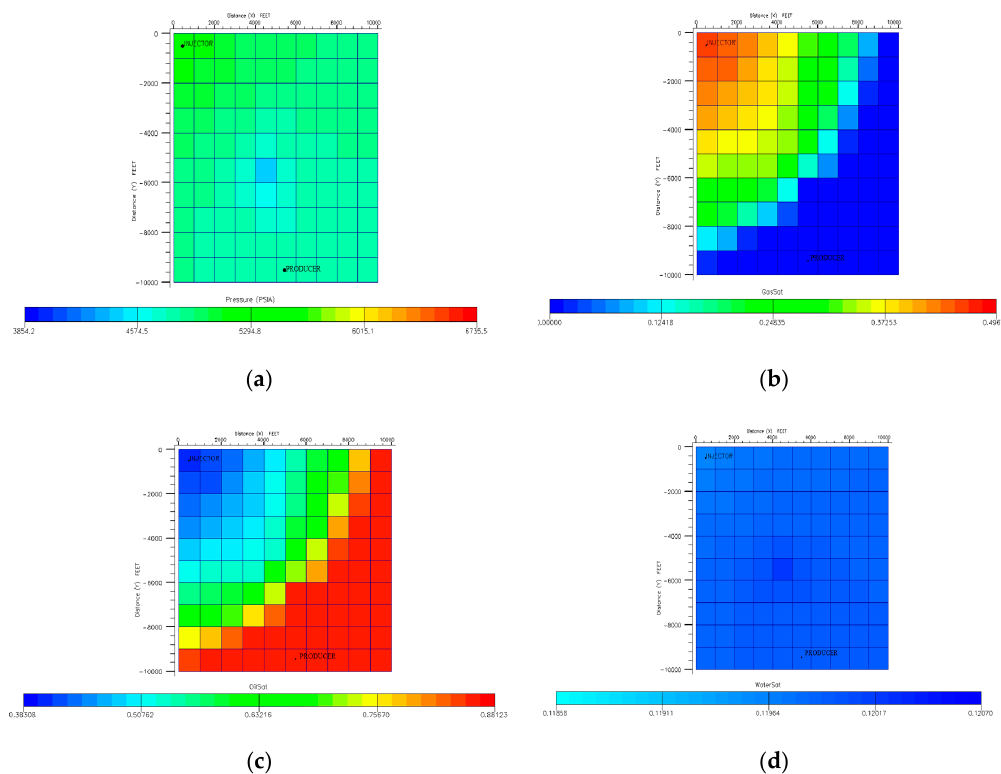
Figure 8. Description for case study 2 ( a – d ), ( a ) Initial pressure, ( b ) Initial gas saturation, ( c ) Initial oil saturation and ( d ) Initial water saturation.